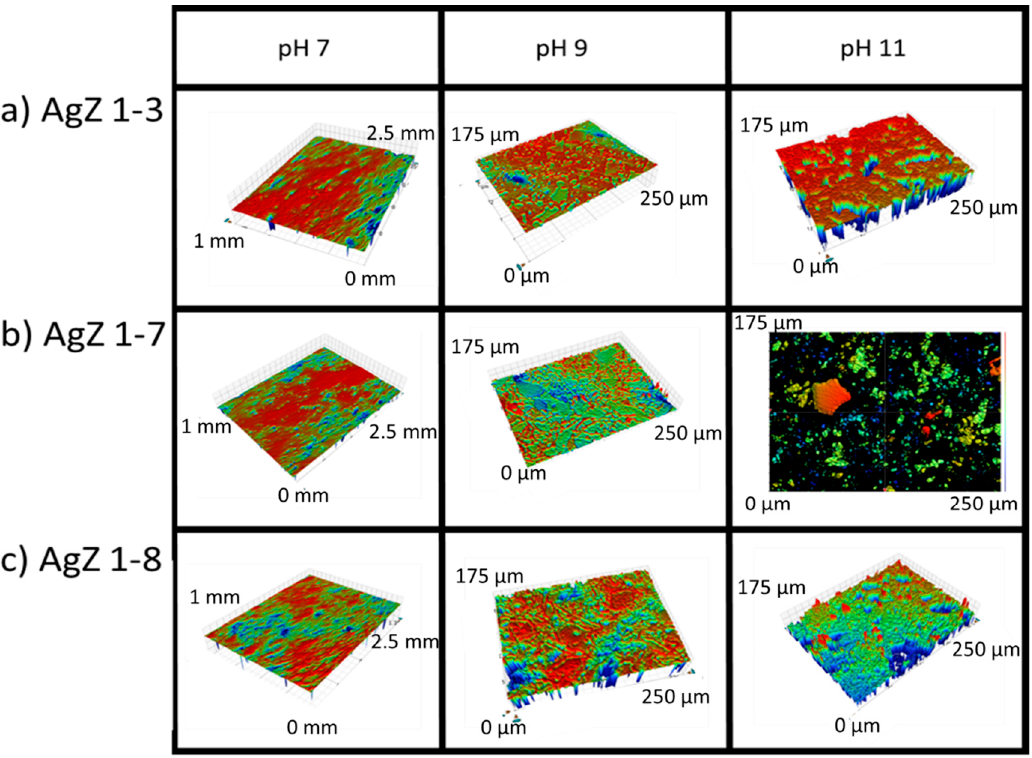
Figure 11. Optical profilometry images of the samples following the SPFT experiments: ( a ) AgZ 1-3; ( b ) AgZ 1-7; and ( c ) AgZ 1-8. At pH 7, the surface could not be resolved at the higher magnification (50 × ) so a lower magnification (5 × ) was used.